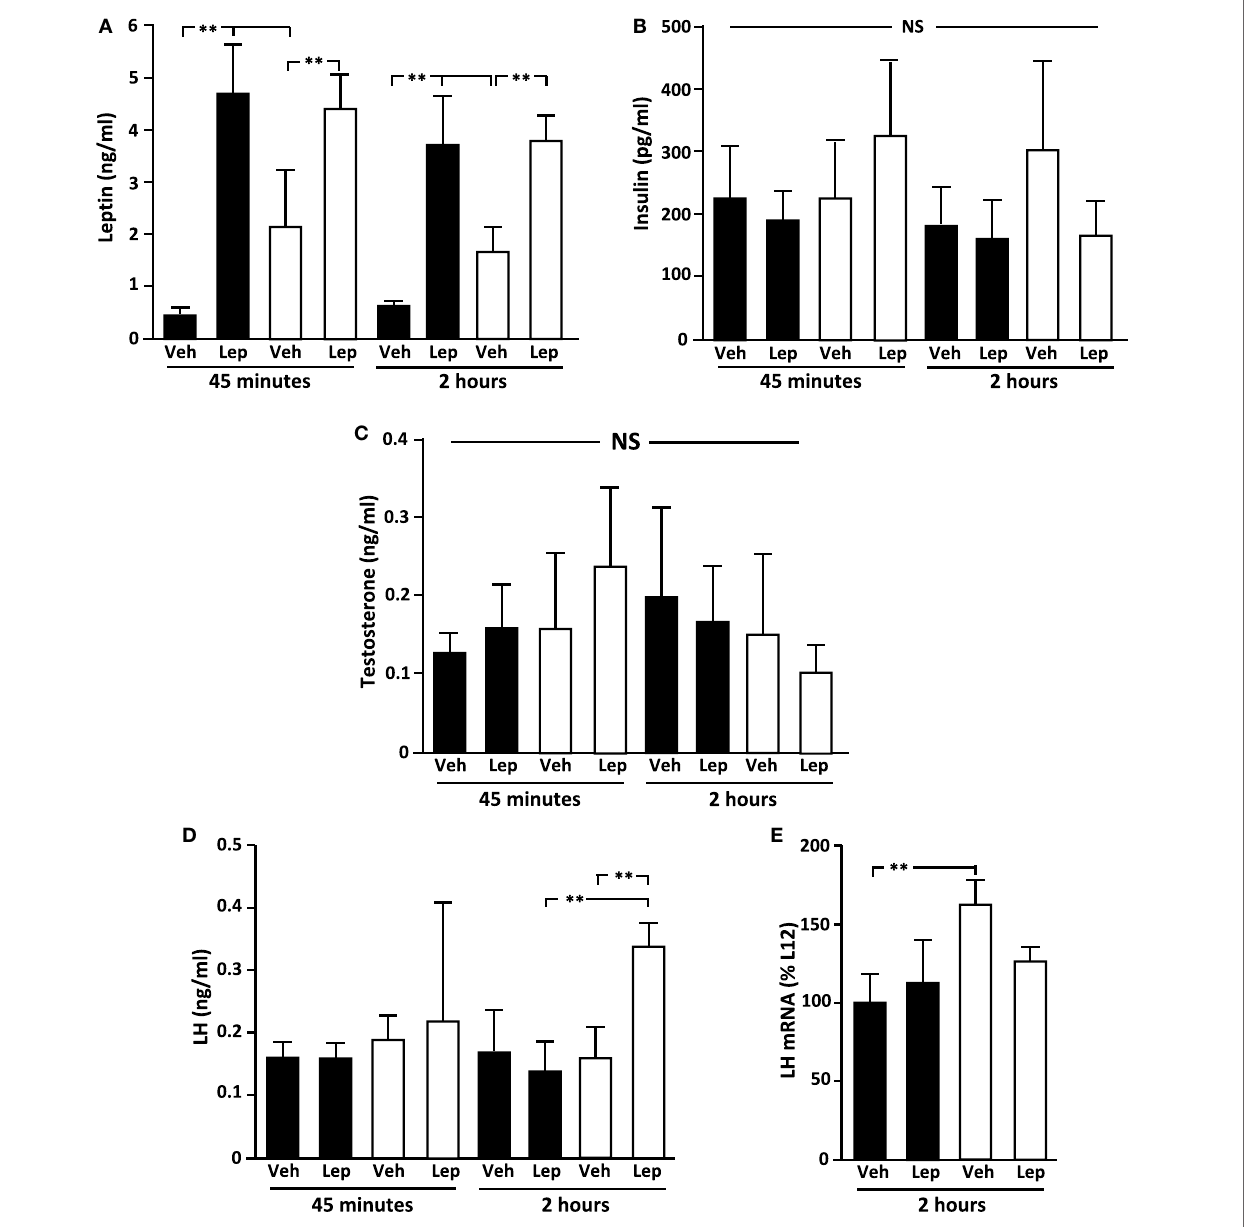
FigUre 2 | Serum (a) leptin, (B) insulin, (c) testosterone, and (D) luteinizing hormone (LH) levels in peripubertal male rats treated with vehicle (Veh) or leptin (Lep; 3 µg/g body weight) at 45 min and 2 h after administration and (e) LH mRNA levels in the pituitary 2 h after administration. Black bars: males raised in litters of 12 pups. White bars: rats raised in litters of 4 pups. ** p < 0.01. NS, non-significant. n = 6/group. Results are presented as mean ±